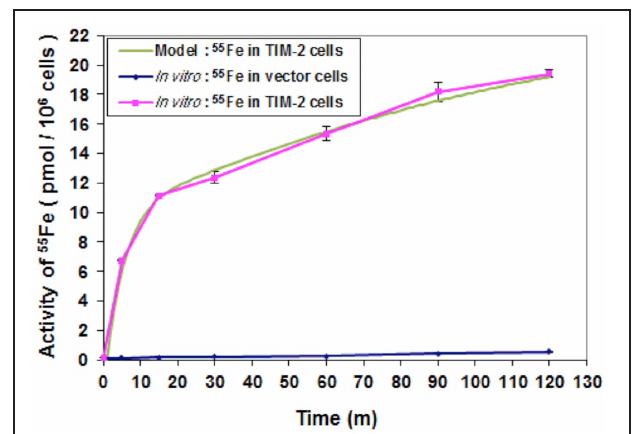
FIGURE 5 | Comparison of iron uptake rates between laboratory data and simulation. Cells were harvested at different time points over a 2-h period and 55 Fe amounts in cytosol fractions were counted. Data shown are means and standard deviations for triplicate replication of the experiment. The experiment was performed in triplicate.